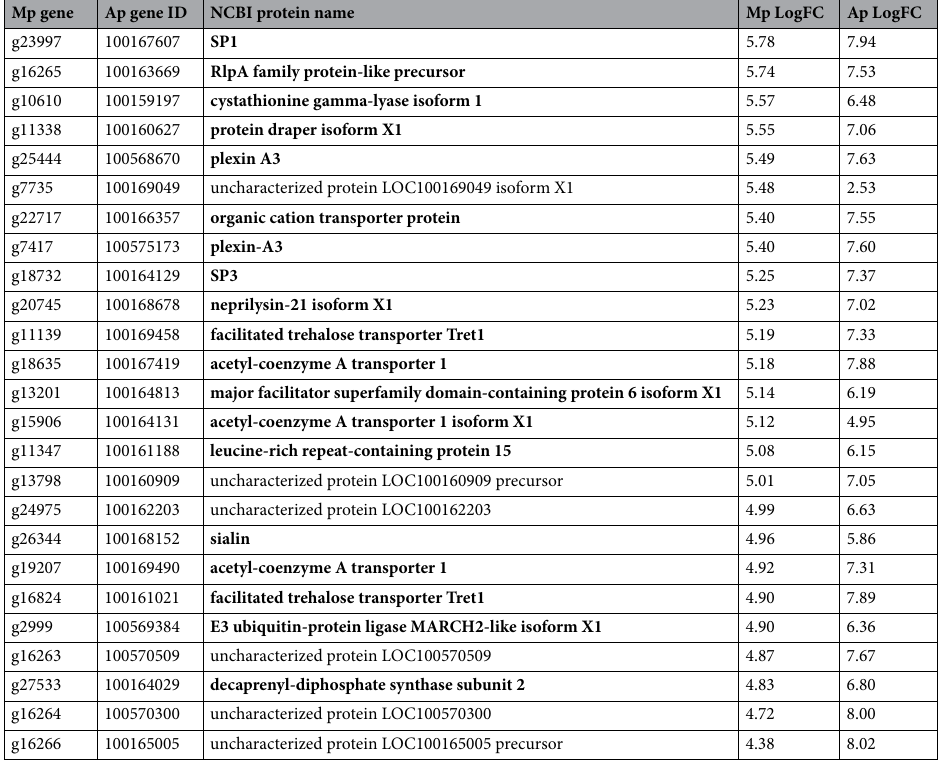
Table 4. The 25 aphid ortholog proteins that were identified with PCA as having the greatest magnitude of up-regulation in the bacteriocyte compared to the body for both aphid species . All proteins in the table were significantly up-regulated in each aphid species ( Mp M. persicae and Ap A. pisum ) where FDR adjusted p-values were ≤ 0.05 with ≥ 1.5-fold change (FC). Bolded proteins indicate those that are characterized with annotations in